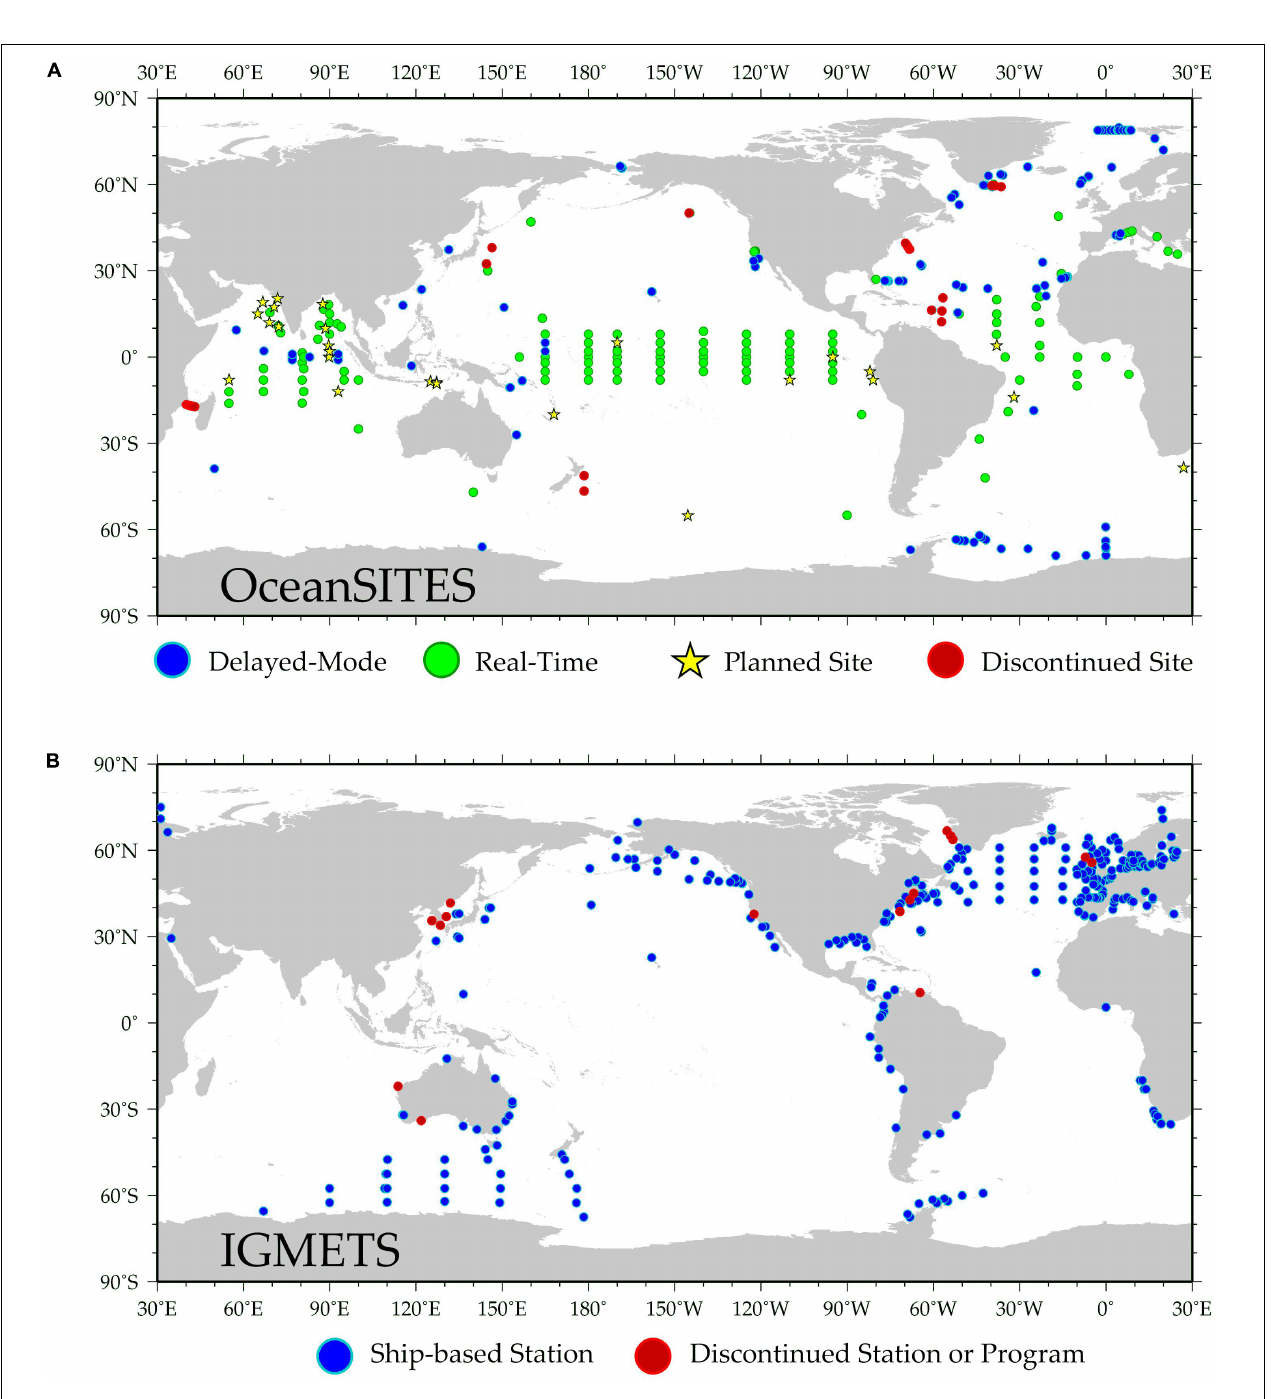
FIGURE 7 | (A) Map of predominantly autonomous ocean observing assets that make up the OceanSITES network (http://www.oceansites.org/). OceanSITES is a worldwide system of long-term, open-ocean reference stations measuring dozens of variables and monitoring the full depth of the ocean from air-sea interactions down to the seafloor. (B) Map of shipboard ocean time series programs that make up the IGMETS network (https://igmets.net/). IGMETS is an activity of IOC-UNESCO that seeks to integrate in situ biogeochemical variables from time series stations, together with satellite-derived information, to look at holistic changes within different ocean